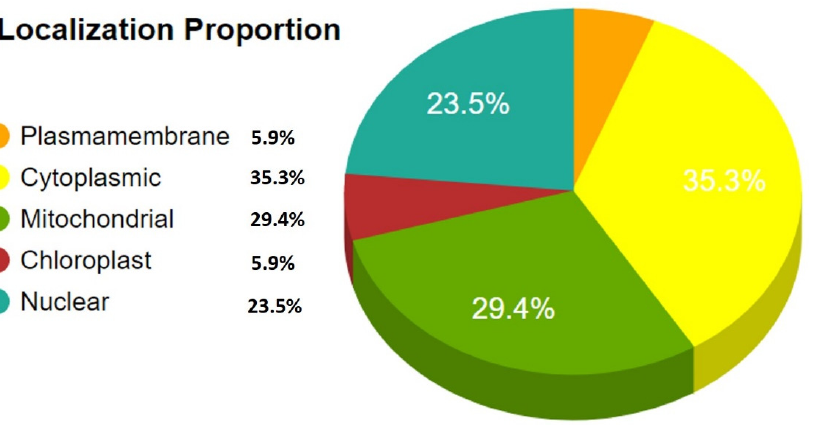
Figure 2. The subcellular localization prediction of the L. tropica essential, human nonhomolog pro- teins. Table 1. The molecular modeling, 3D structure validation, and druggability analysis of the priori- tized shortlisted proteins of L. tropica .